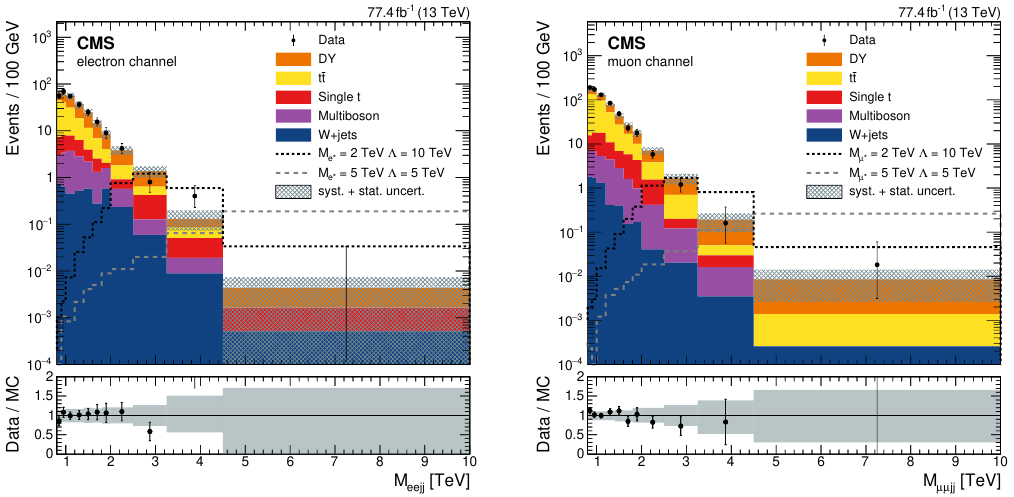
Figure 7 . Distribution of the two-lepton two-jet invariant mass in the signal region ( M 500 GeV) for the electron (left) and muon (right) channels. The example signal shape for two excited lepton masses is indicated as a gray line with the parameters given in the legend and for the benchmark case where the couplings f and f 0 are set to unity. The lower panels show the ratio of data to simulation with the total uncertainty in